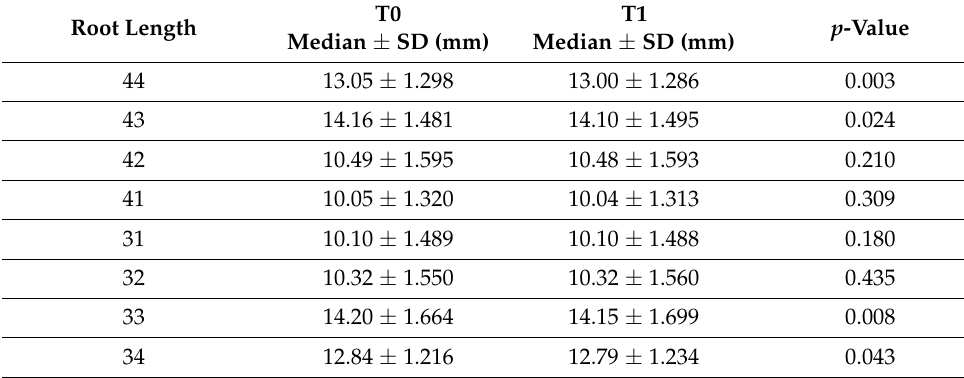
Table 8. Root length at T0 and T1 for mandibular